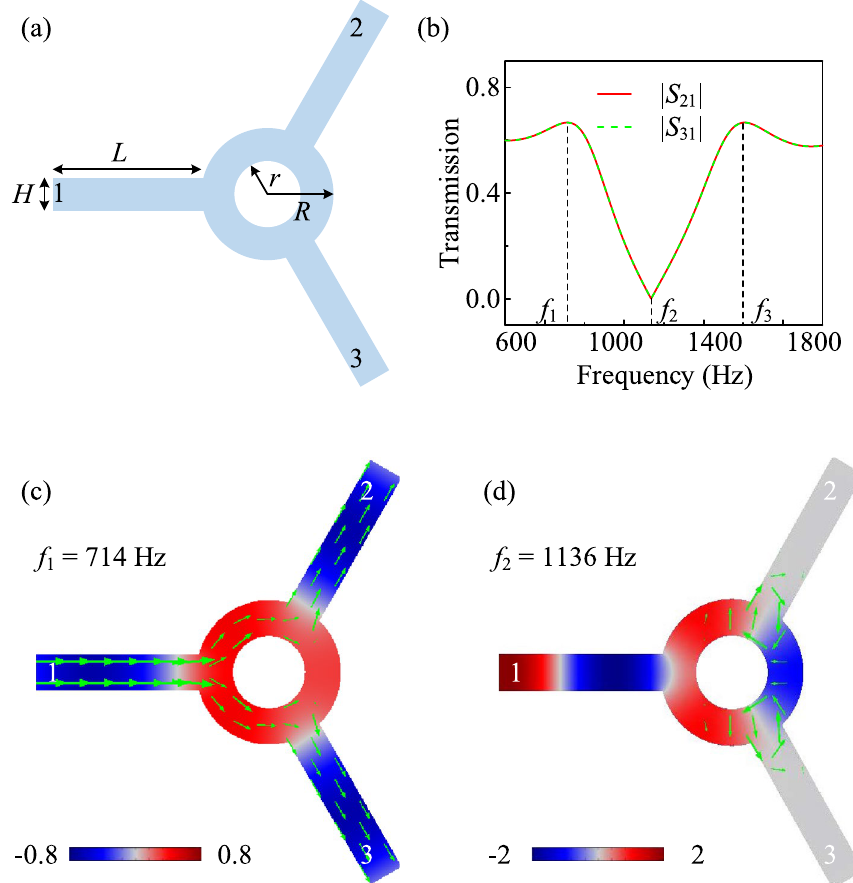
Figure 1. Schematic of an unbiased acoustic three-port device. ( a ) The geometry of the proposed device. ( b ) The amplitudes of the pressure transmission coefficients at ports 2 and 3 in the absence of extra bias. ( c , d ) Acoustic pressure field distributions inside the device at f 1 = 714 Hz ( c ) and f 2 = 1136 Hz ( d ). Green arrows represent the average acoustic power flow in ( c , d